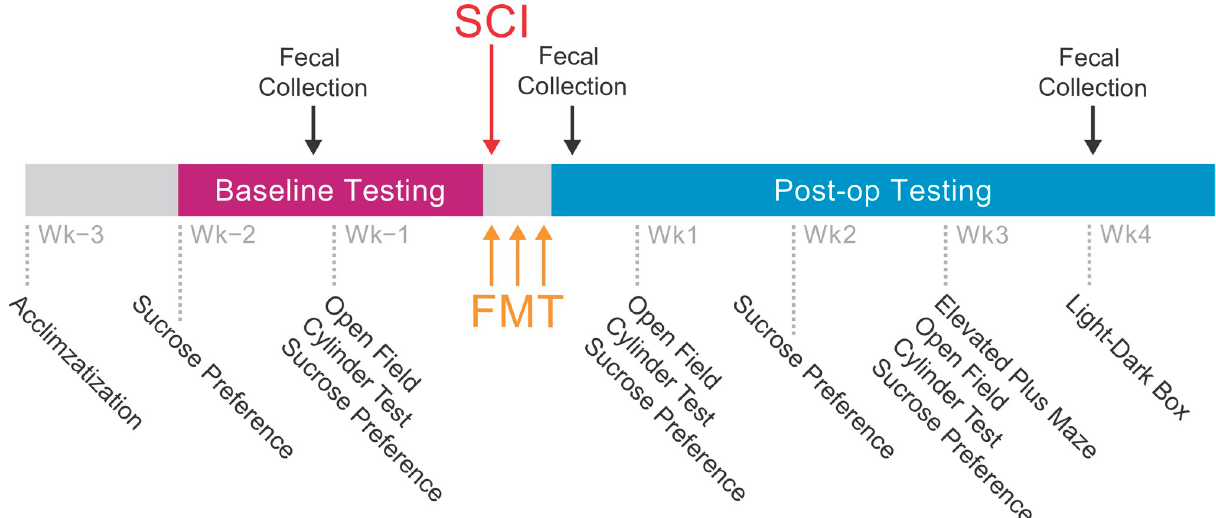
Fig 2. Experimental Timeline. Upon arrival, rats were allowed one week to acclimate to their environment before testing. Prior to injury, baseline measures were obtained in the cylinder test, open field, light-dark box and sucrose preference tests. With the exception of the healthy group, all rats were gavaged with a fecal slurry (FMT: fecal microbiota transplant) or control solution at the time of injury and for 2 days following injury or sham surgery. Stool samples were collected for 16s rRNA sequencing prior to, 3 days and 4 weeks following surgeries. After surgeries, rats were tested weekly on a battery of behavioural tests followed by perfusions (5 weeks following surgeries) and tissue